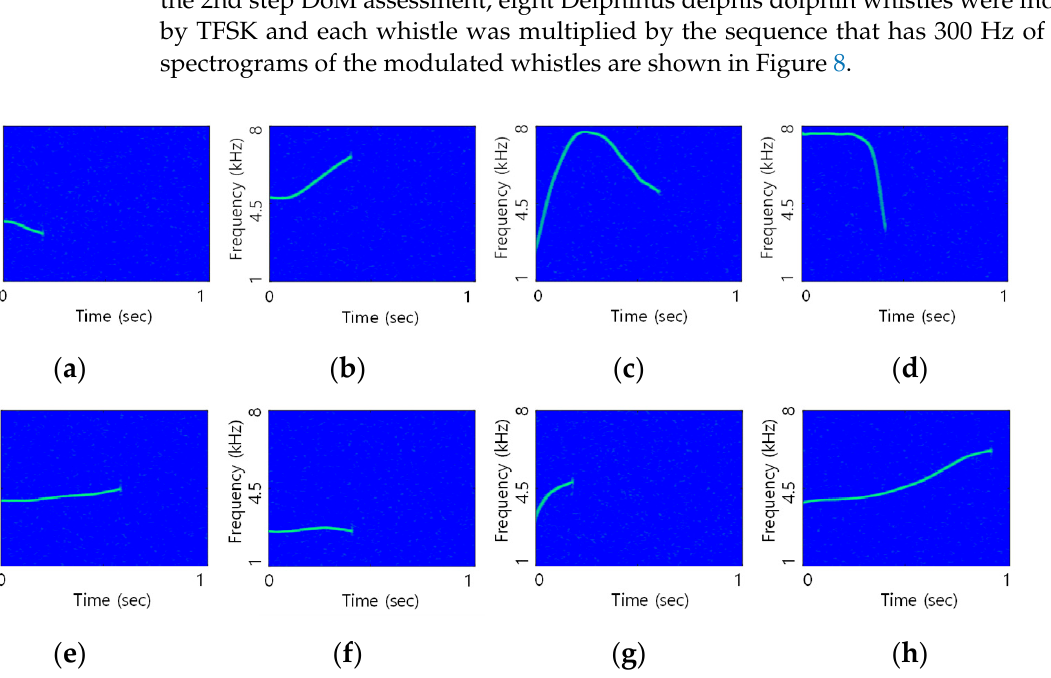
Table 6. Average MOS result for the 2nd assessment.